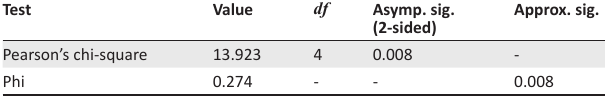
TABLE 4: Kepner-Tregoe technique versus step-by-step decision-making process.